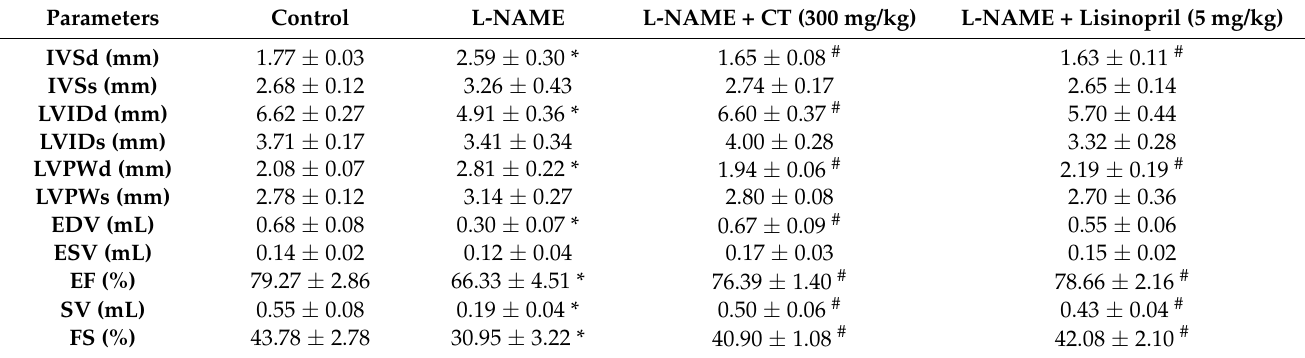
Table 3. Effects of CT extract and lisinopril on ventricular dysfunction in all groups of the experiment.